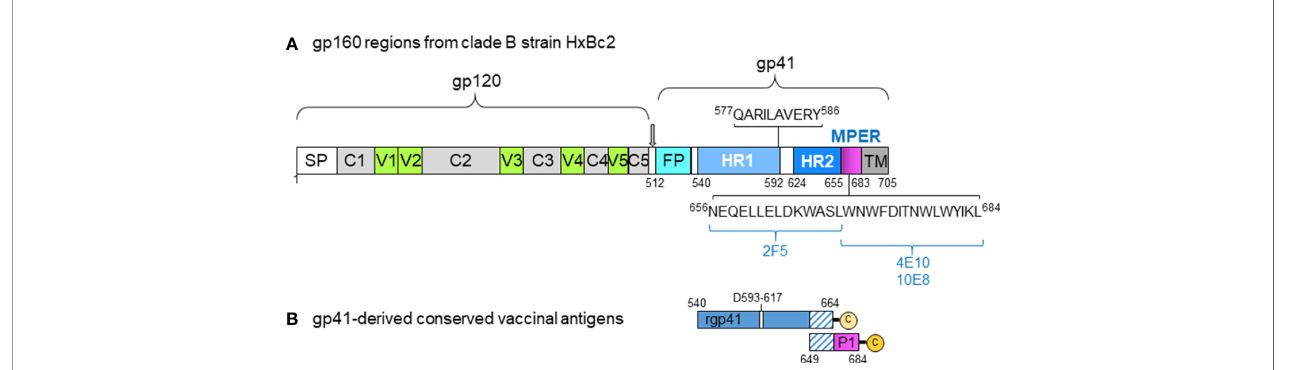
FIGURE 1 | HIV gp41-derived antigens used with virosomes. (A) Scheme illustrating the various regions of HIV gp120 and gp41 with the signal peptide (SP), variable regions #1 to #5 (V1-V5), conserved domains #1 to #5 (C1-C5), gp41 fusion peptide (FP), the two helix regions 1 and 2 (HR1 and HR2), the membrane- proximal external region (MPER), and the transmembrane domain (TM). The numbers indicated correspond to the amino acid position in the HxBc2 gp160 sequence, with some of the key neutralizing gp41 epitope sequences (QARILAVERY, 2F5, 4E10, 10E8) to show their location. (B) The recombinant gp41 antigen (rpg41) covers the amino acid sequence 540-664 with a deletion from 593-617, followed by leucine and glutamic residues from the cloning site and a 4-histidine tag sequence ending with a C-terminal cysteine for lipidation. The last 16 rgp41 residues on the C-terminal end (residues 649-664) overlap with the fi rst 16 amino terminal residues of the P1 peptide. Of note, the originally described P1 sequence covers the gp41 residues 649-683, and it was subsequently modi fi ed by adding the natural leucine residue (649-684) on the C-terminal end, followed by serine and cysteine residues to improve peptide solubility, stability, upscaling as well as allowing lipidation. This modi fi ed P1 sequence and the rgp41, respectively, were anchored onto separate virosomes and used for nonhuman primate